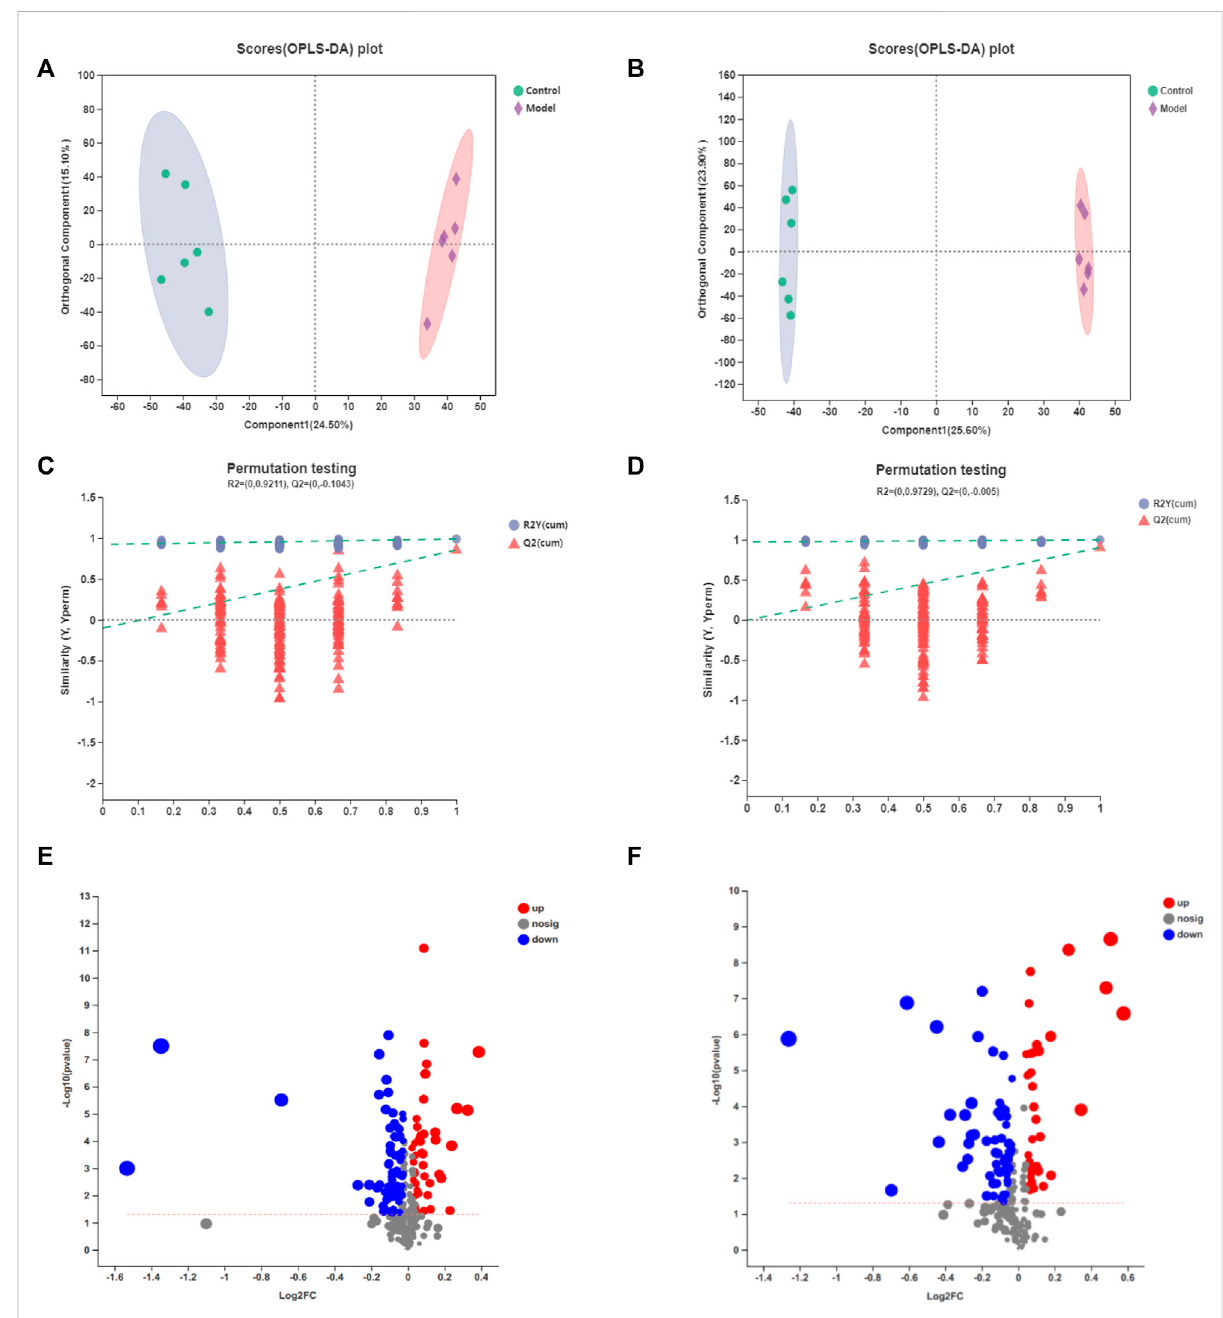
FIGURE 5 OPLS-DA score diagrams of the samples from control vs. model in the positive mode (A) or negative mode (B) ; 7-fold cross-validation plot of the OPLS-DA model with 200 permutation tests in the positive mode (C) or negative mode (D) ; volcano plots of the samples from control vs. model in the positive mode (E) or negative mode (F) . Ellipse expresses that the con fi dence interval is